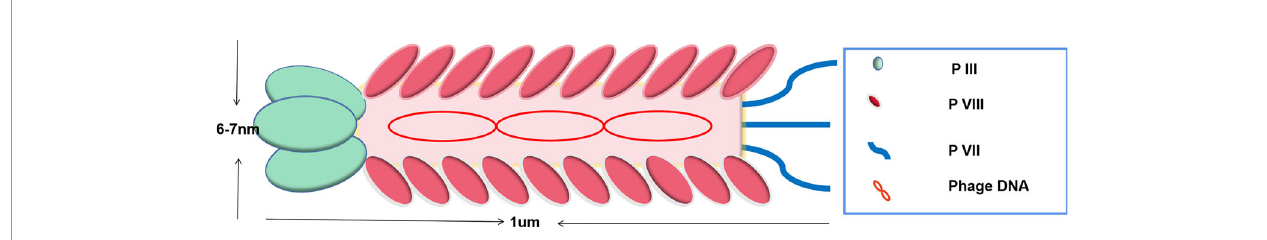
FIGURE 1 | Schematic of Ff phage. Phage consists of a tubular protein coat surrounding a single-stranded circular DNA. Proteins III and VII are the minor coat proteins, present in 3-5 copies. Protein VIII is the major phage coat protein and presents in 2700 copy